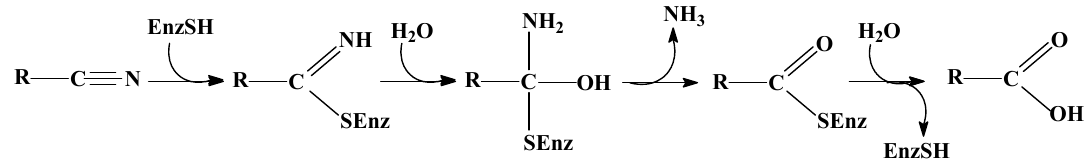
Figure 1. Proposed general reaction mechanism for nitrilases.